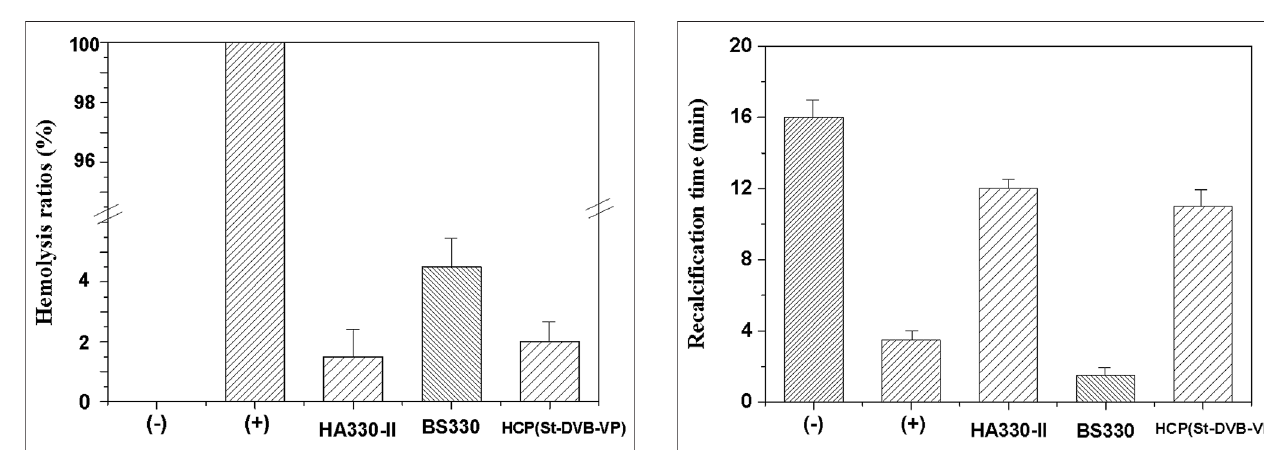
FIGURE 11 | Recalci fi cation time of the controls and adsorbents. (+) Hydrophilicglassbeads,( − )blanktube.Thedataareexpressedasthemean ± SD of three independent